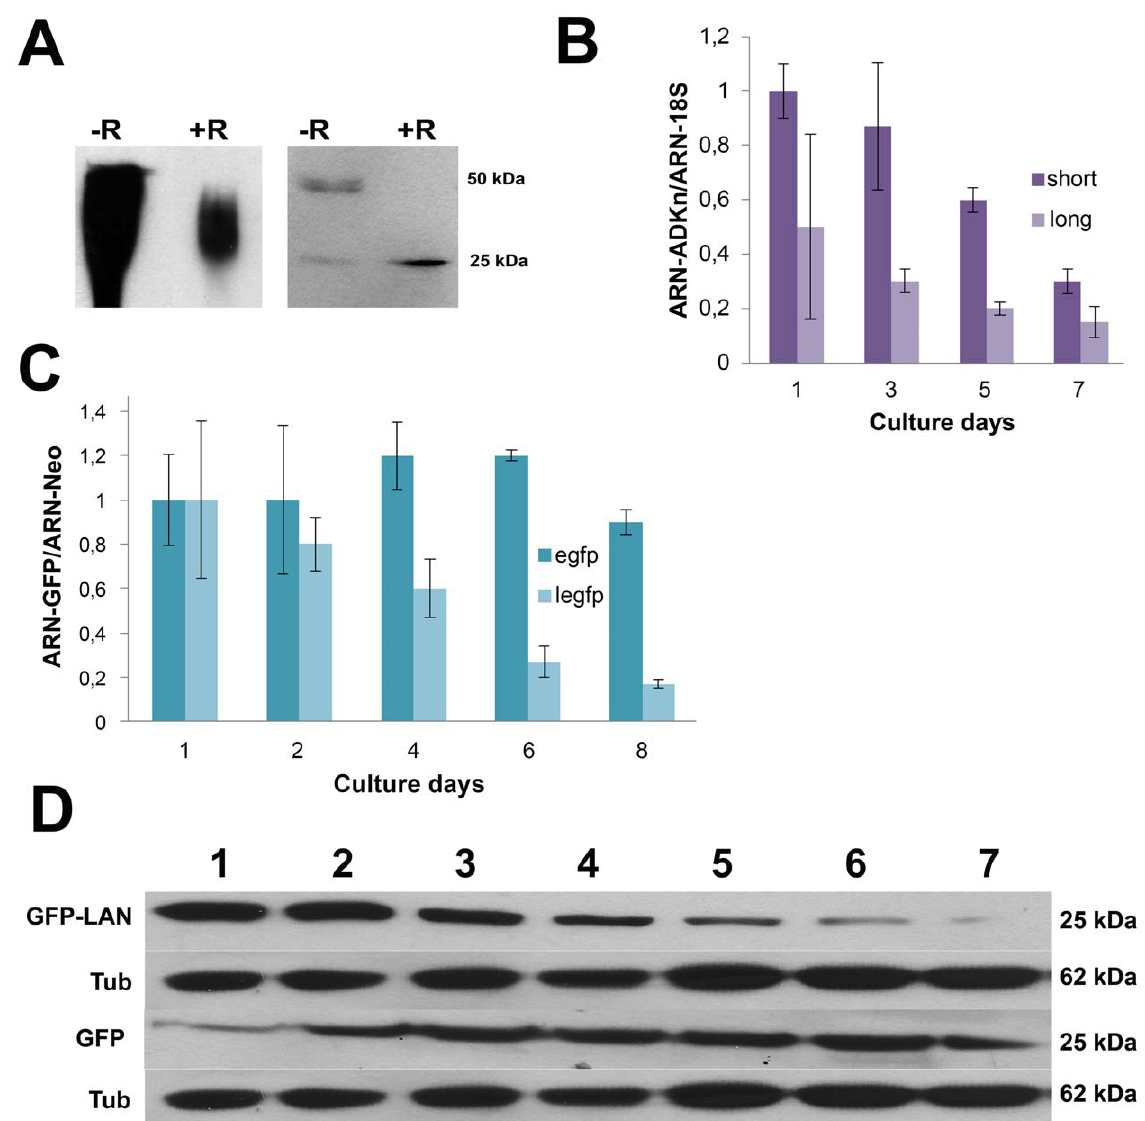
Figure 6. Regulation of TcADKn mRNA. A) TcADKn interaction with RNA 1 6 10 8 epimastigotes in day 2 of culture grown in BHT medium were harvested, and resuspended in Tris-HCl buffer pH 7,4 and broken by 3 cycles of freezing and thawing. Native and denaturing 8% PAGE followed by Western Blot against TcADKn using samples of epimastigotes from day 2 of culture treated ( + R) or not ( 2 R) with RNAase I (10 mg.mL 2 1 ) for 2 h. at 37C. SDS- PAGE Band intensities were normalized using anti-Tubulin antibodies, quantified and represented using a bar graphic. B) Real time PCR quantifying the two mRNAs found for TcADKn along the epimastigotes growth curve. The value obtained for the short transcript in day one was taken as 1. Data were relativized to the 18S. C) Real time PCR along the epimastigotes growth curve of transgenic parasites expressing the pTREX- OMNI or pTREX-OMNI LAN (3 9 UTR) construction. The value obtained for GFP of the pTREX-OMNI construct was taken as 1. Data were relativized to the neo gene found in the expression vector. D) Western Blot analysis of GFP expression along the growth curve of parasites expressing pTREX-OMNI or pTREX-OMNI-LAN construction. Tubulin (TUB) was used as load control. Each lane corresponds to 4 6 10 6 parasites.